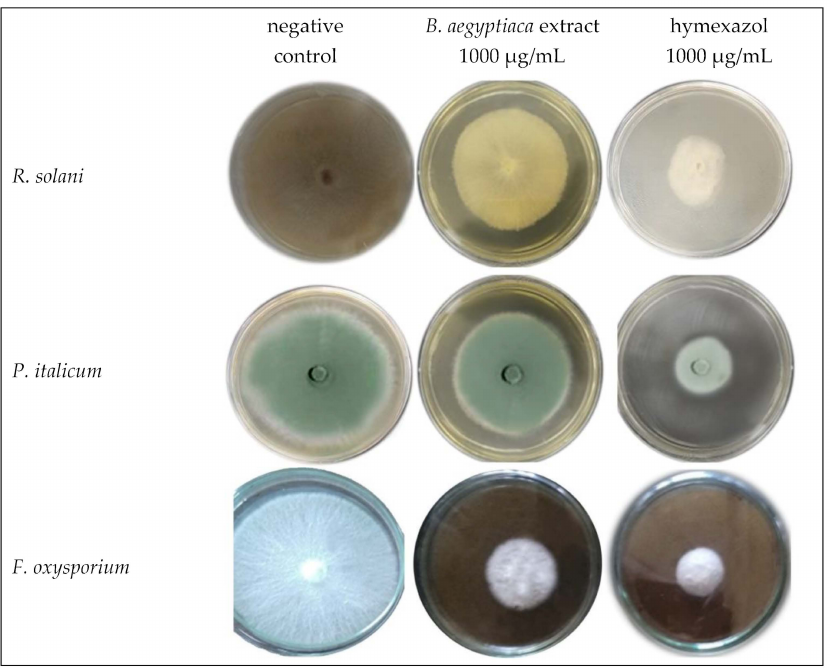
Figure 5. Growth inhibition of three fungal species: Rhizoctonia solani , Penicillium italicum, and Fusarium oxysporium , on PDA medium in response to the treatment with B. aegyptiaca methanolic fruit extract at the highest concentration (1000 µ g/mL) compared with the negative control and hymexazol at 1000 µ